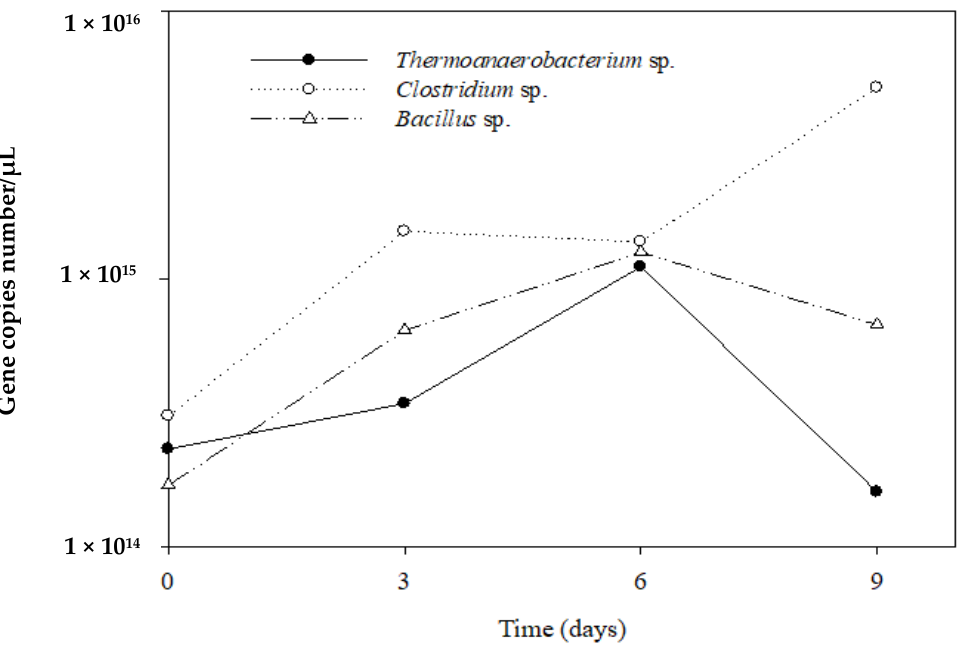
Figure 6. Real-time monitoring of Clostridium sp., Thermoanaerobacterium sp., and Bacillus sp. genome amplification during hydrogen production from sawdust.